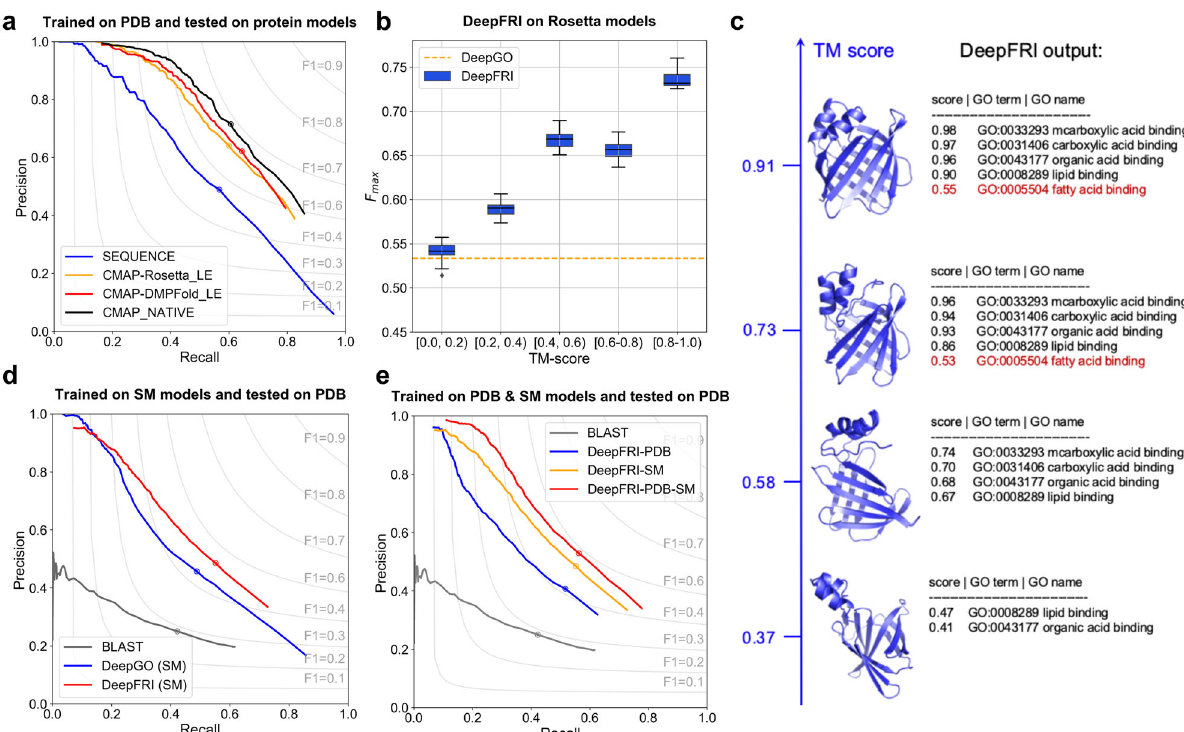
Fig. 2 Performance of DeepFRI in predicting MF-GO terms of experimental structures and protein models. a Precision-recall curves showing the performance of DeepFRI on ~700 protein contact maps (PDB700 dataset) from NATIVE PDB structures (CMAP_NATIVE, black), their corresponding Rosetta-predicted lowest energy (LE) models (CMAP-Rosetta_LE, orange) and DMPfold lowest energy (LE) models (CMAP-DMPFold_LE, red), in comparison to the sequence-only CNN-based method (SEQUENCE, blue). All DeepFRI models are trained only on experimental PDB structures. b Distribution of protein-centric F max score over 1500 different Rosetta models from the PDB700 dataset grouped by their TM-score computed against the native structures. Data are represented as boxplots with the center line representing the median, upper and lower edges of the boxes representing the interquartile range, and whiskers representing the data range (0.5 × interquartile range). c An example of DeepFRI predictions for Rosetta models of a lipid- binding protein (PDB id: 1IFC) with different TM-scores computed against its native structure. The DeepFRI output score >0.5 is considered as a signi fi cant prediction. Precision-recall curves showing the: d performance of our method, trained only on PDB experimental structures, and evaluated on homology models from SWISS-MODEL (red), in comparison to the CNN-based method (DeepGO) trained only on PDB sequences, and BLAST baselines are shown in blue and gray, respectively; e performance of DeepFRI trained on PDB (blue), SWISS-MODEL (orange) and both PDB and SWISS-MODEL (red) structures in comparison to the BLAST baseline (gray). The dot on the curve indicates where the maximum F-score is achieved (the perfect prediction should have F = 1 at the top right corner of the max